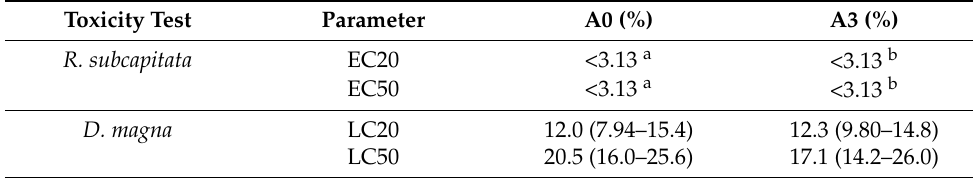
Table 3. Effective concentrations (in %) inducing 20 (EC20) and 50% (EC50) inhibition of growth for the toxicity tests performed with Raphidocelis subcapitata (72 h growth) and lethal concentrations (in %) provoking 20 (EC20) and 50% (EC50) lethality for the toxicity tests performed with Daphnia magna (48 h lethality), along with respective 95% confidence limits in brackets, on the non-treated (A0) and treated (A3) electroflotation wastewater contaminated with the sulfonylurea herbicide